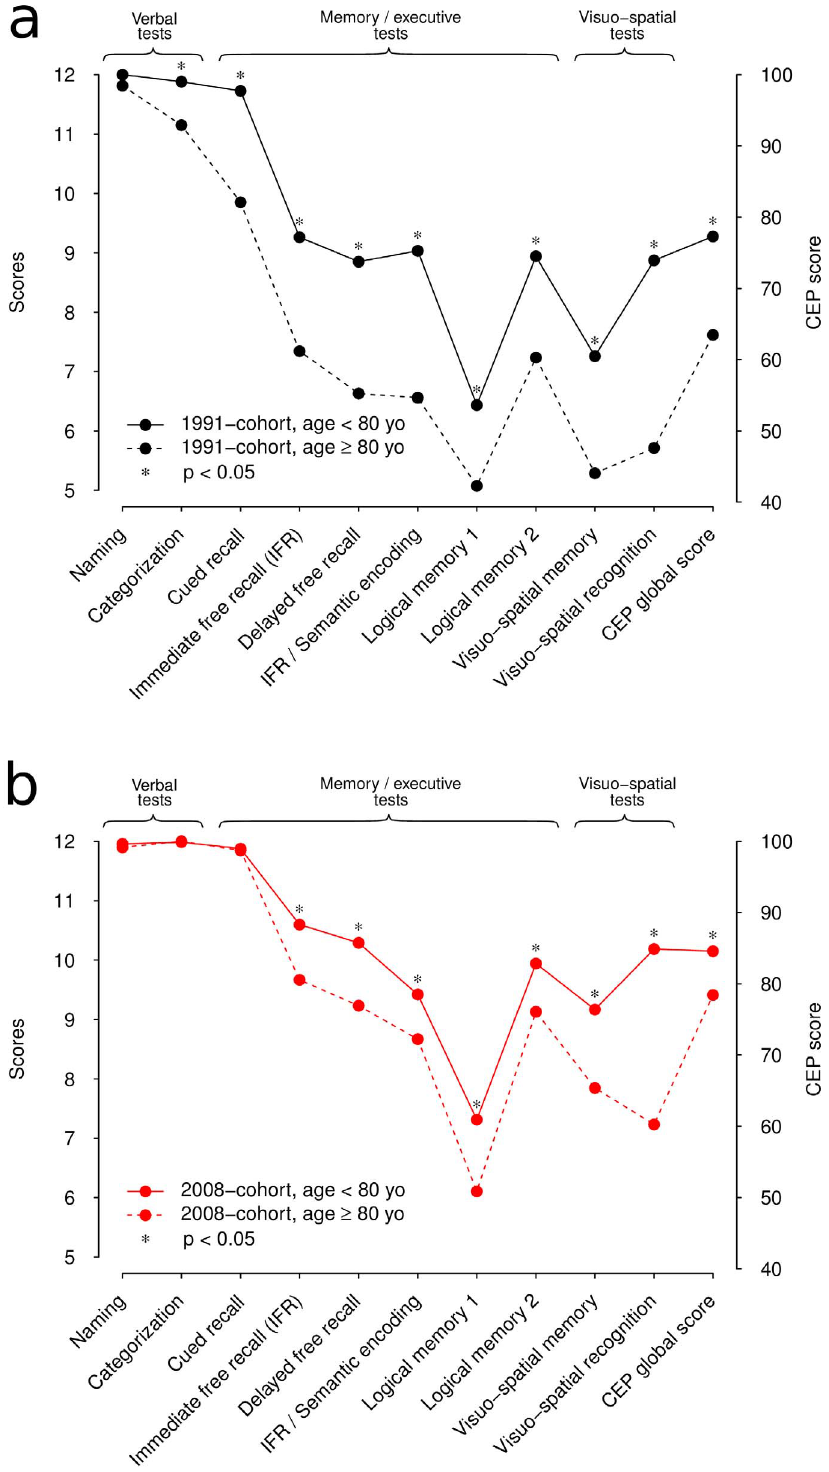
Figure 2. Comparison between participants , 80 yo and participants $ 80 yo. in the 1991-sample (a) and in the 2008-sample (b).